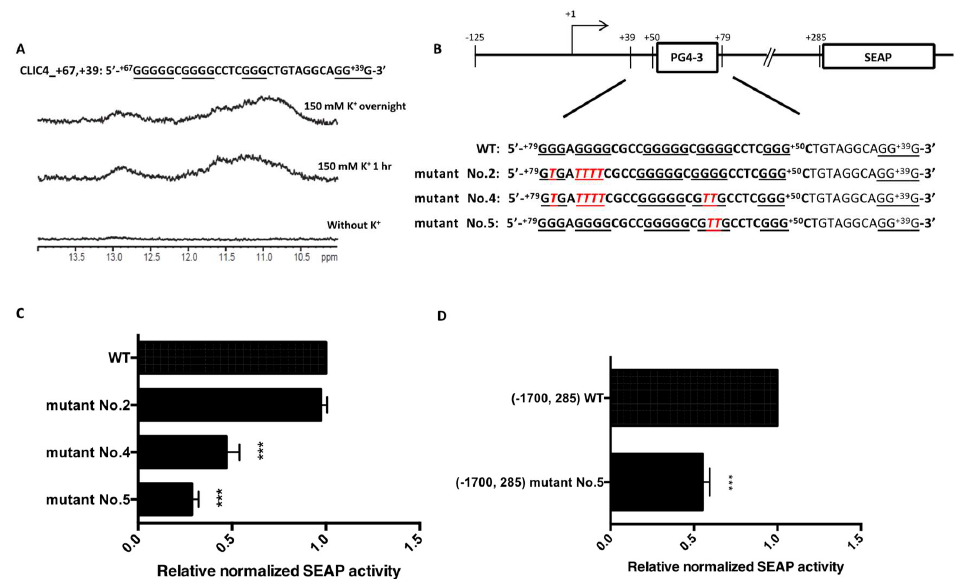
Figure 4. Further disruption of the remaining possible G4 structure formed in the Mutant No. 2 reporter plasmid. ( A ) NMR analysis of CLIC4 +67 to +39, the possible G4-forming sequence in Mutant No. 2 in Tris-HCl buffer and 150 mM KCl, for 1 h and overnight; ( B ) Sequence of WT and mutants derived from Mutant No. 2—Mutants No. 4 and No. 5 contain the following G-tract at the 3′ end. The original PG4-3-forming region is shown in bold letters, G-tracts are underlined, and the mutated sequences in CLIC4 p(−125, +285) plasmids are marked in red italicized letters; ( C ) SEAP activity of CLIC4 p(−125, +285) mutants further disrupting the G4 forming motif in Mutant No. 2 were determined in A375 cells after transfection for 72 h. Data were expressed as the means ± SD of three replicates. *** p < 0.001 as compared to the WT. ( D ) SEAP activity of CLIC4 p( − 1700, +285) mutant No. 5 in A375 cells after transfection for 72 h. Data were expressed as means ± SD of three replicates. *** p < 0.001 as compared to CLIC4 p( − 1700, +285) WT.